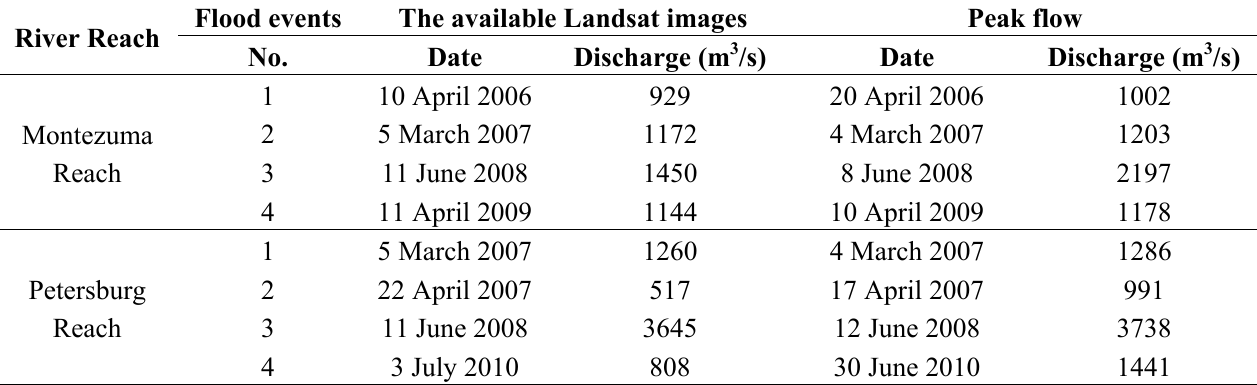
Table 1. The Landsat Imageries used in this